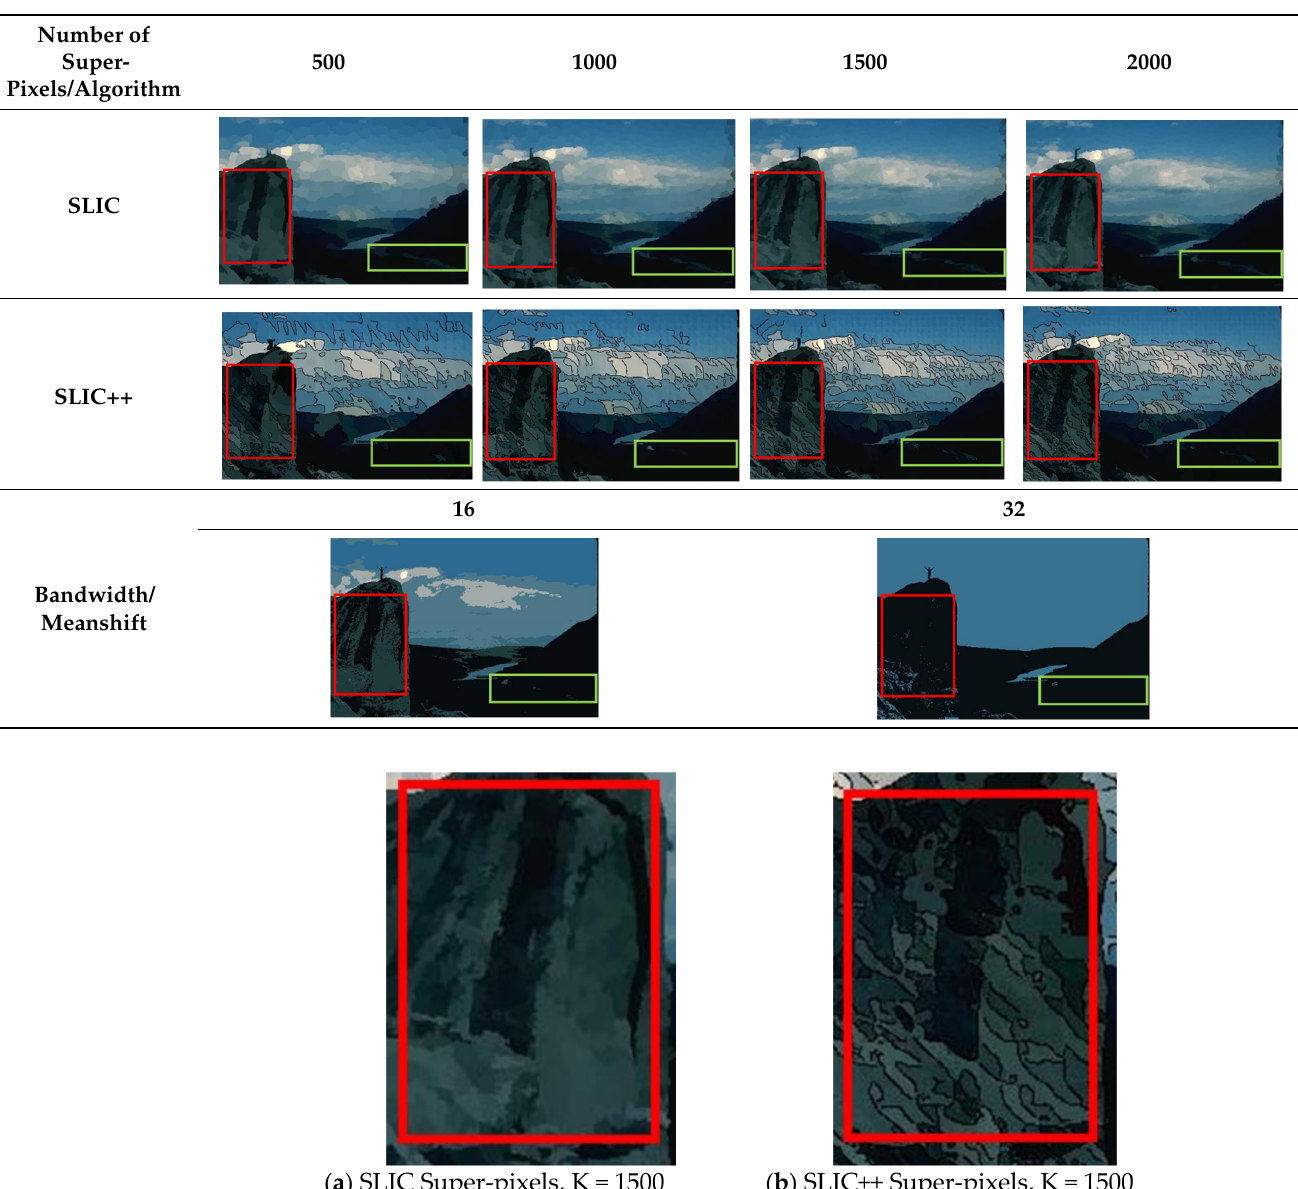
Table 6. Detailed perceptual analysis with increasing parameters.